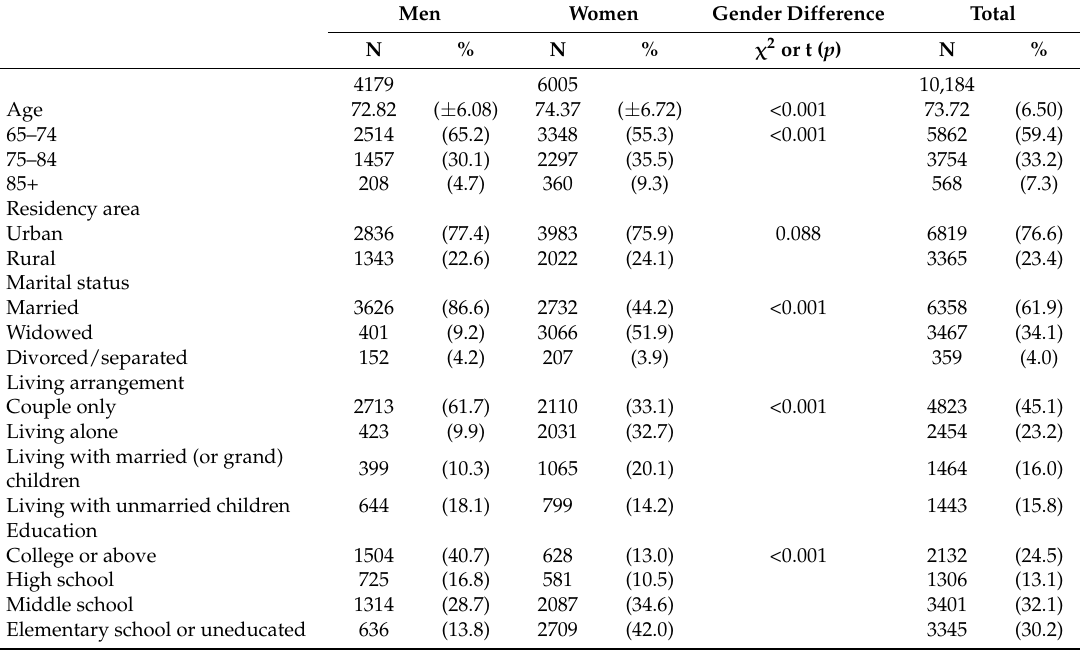
Table 1. Sociodemographic and health characteristics of community-dwelling men and women aged 65 years and older in